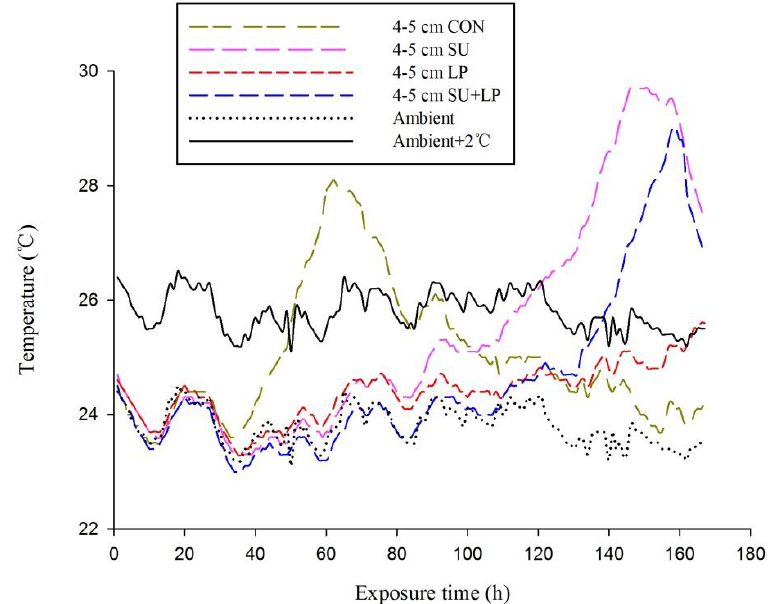
Figure 2. The temperature changes of L. chinensis silage at a length of 4–5 cm with the time of aerobic exposure. CON, control; SU, sucrose; LP, Lactobacillus plantarum. Table 4. Significant analyzes of length, additive, and their interactions on aerobic stability, maxi- mum temperature and the time to maximum temperature of L. chinensis silage.